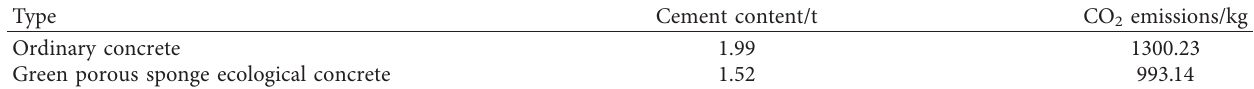
Table 4: Economic and environmental protection of